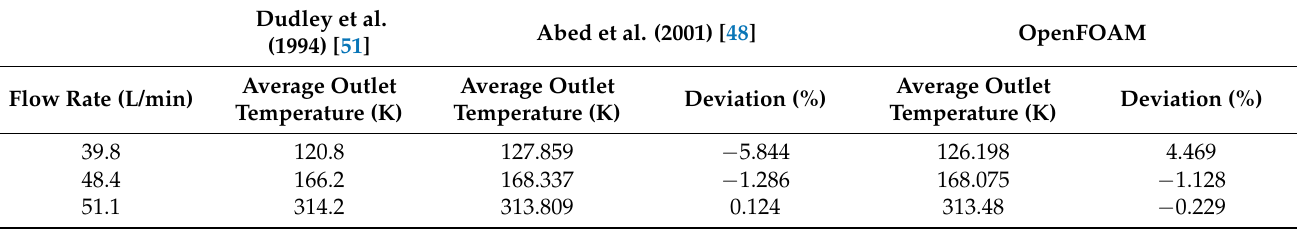
Table 3. A comparison between the experimental data [51], numerical simulation data [48] in literature, and the CFD calculation in our study.